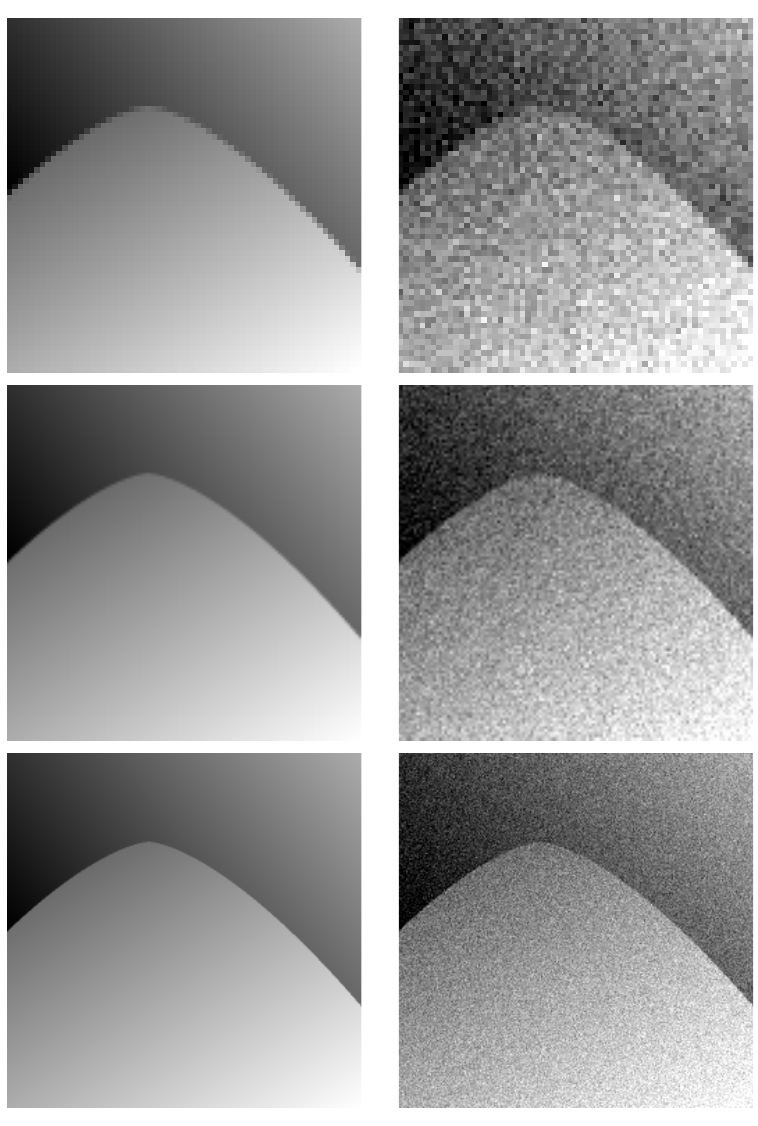
Figure 2. ( Left ) δ n f , for n = 64 , 128 , 256 , respectively, where f is a horizon function, according to Definition 2. Here, the horizon boundary is in C α ((0 , 1)) and α = 1 . 5 ; ( Right ) Respective noisy images δ n f + ξ n